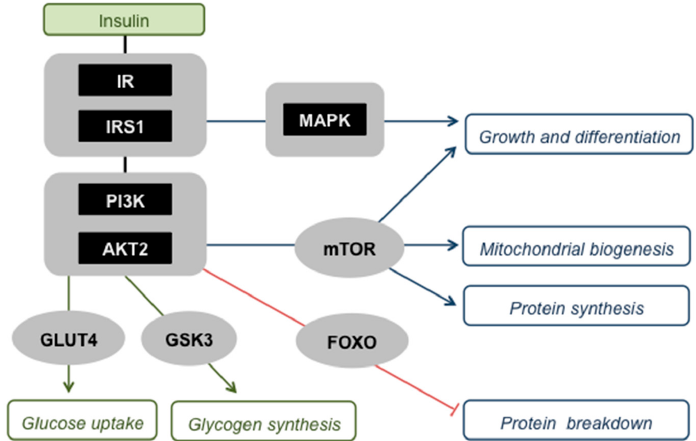
Figure 1. Skeletal muscle insulin signalling. Insulin activates its receptor (IR) and receptor substrate (IRS1), which comprise a ‘critical node’ in a branched signalling network that allows interaction with other pathways, for example those induced by cytokines [15]. Activation of this node triggers two major protein kinase cascades, i.e., the phosphatidylinositol-3-kinase (PI3K)—protein kinase B (AKT2 in skeletal muscle) pathway and the Ras-mitogen-activated protein kinase (MAPK) pathway, which both instruct muscle cells to engage with anabolic processes. Activated AKT2 has multiple effects: (i) It stimulates recruitment of the glucose transporter protein (GLUT4) to the plasma membrane, and is thus responsible for insulin-sensitive glucose uptake by muscle; (ii) it activates glycogen synthesis by inhibiting glycogen synthase kinase-3 (GSK3); (iii) it promotes mitochondrial biogenesis, protein synthesis, and cell growth and differentiation, effects that are all mediated through the stimulation of the mammalian target of rapamycin (mTOR); (iv) it suppresses protein breakdown by phosphorylating and thus deactivating Forkhead box O (FOXO) transcription factors that stimulate proteasome- and lysosome-mediated proteolysis. The MAPK pathway acts in concert with AKT2 to transmit insulin’s message to increase cell growth and differentiation.